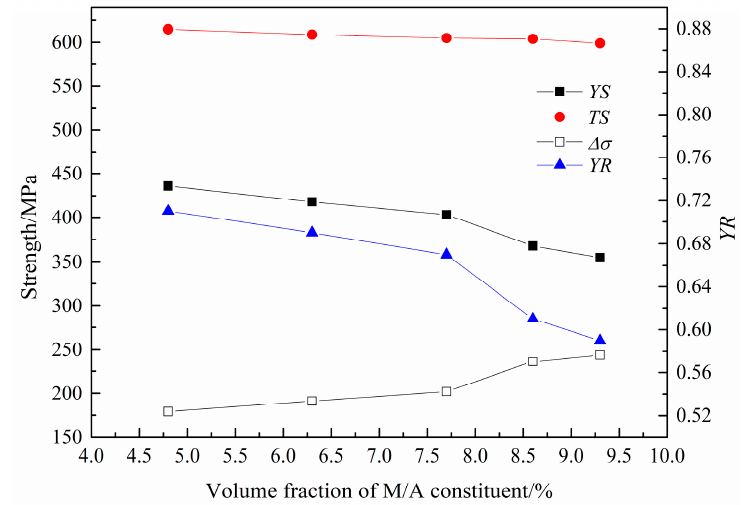
Figure 12. TS , YS , Δ σ , and YR of different samples as functions of the portion of the M ‐ A constituent, f M ‐ A . M ‐ A—martensite ‐ austenite, YS —yield strength, TS —tensile strength, Δ σ —magnitude for strain hardening, YR —yield ratio.